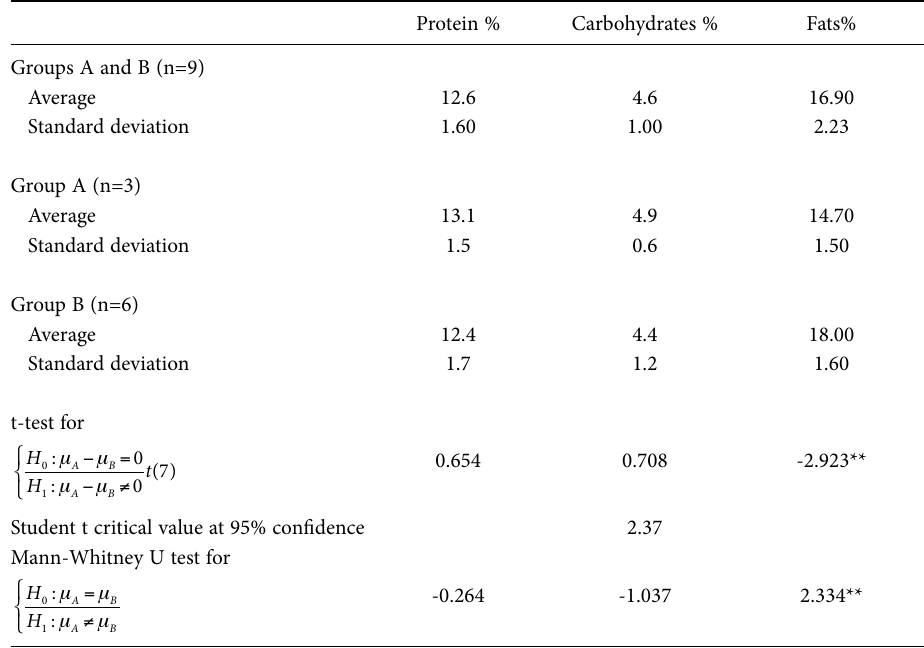
Table 3. Statistical analyses of group means.